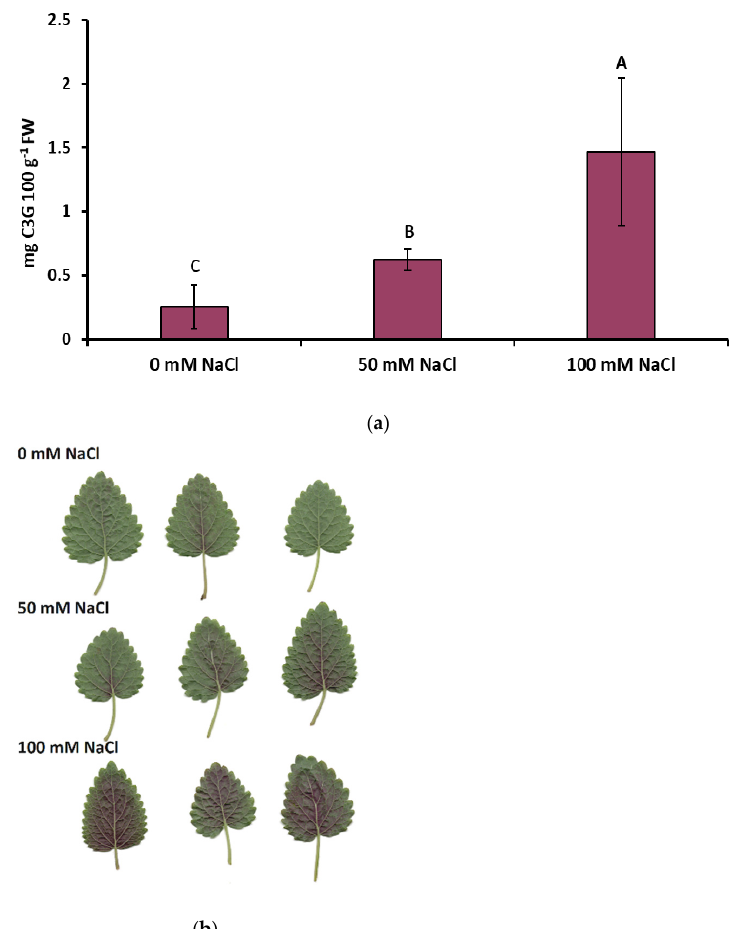
Figure 6. Effect of the NaCl concentration on ( a ) the foliar concentration of anthocyanins (as cyanidin 3-glycoside; C3G) and ( b ) pigmentation of the lower epidermis of Melissa officinalis leaves after 10 days of salt exposure. Data are means ± SD ( n = 4). Means followed by different letters differ statistically significantly ( p < 0.05, Tukey’s test).